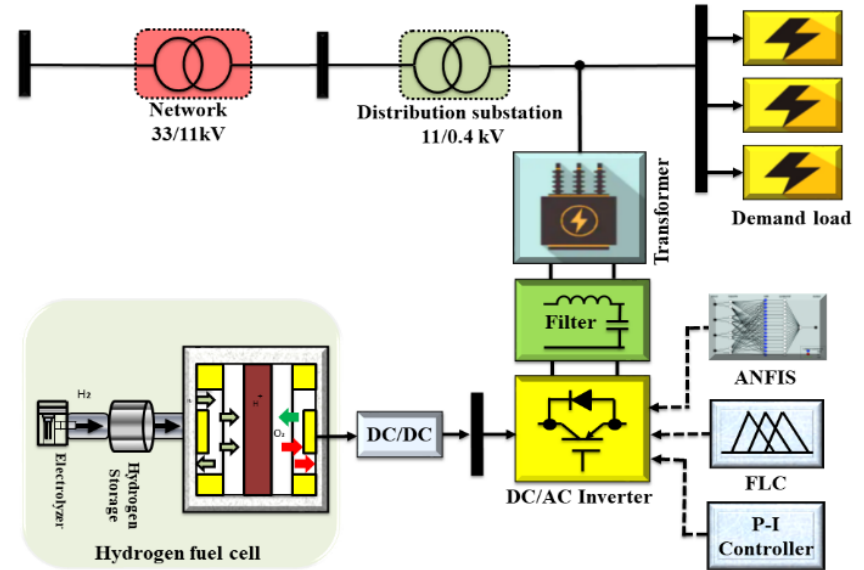
Figure 11. The block diagrams and the location of HFC D-STATCOM.